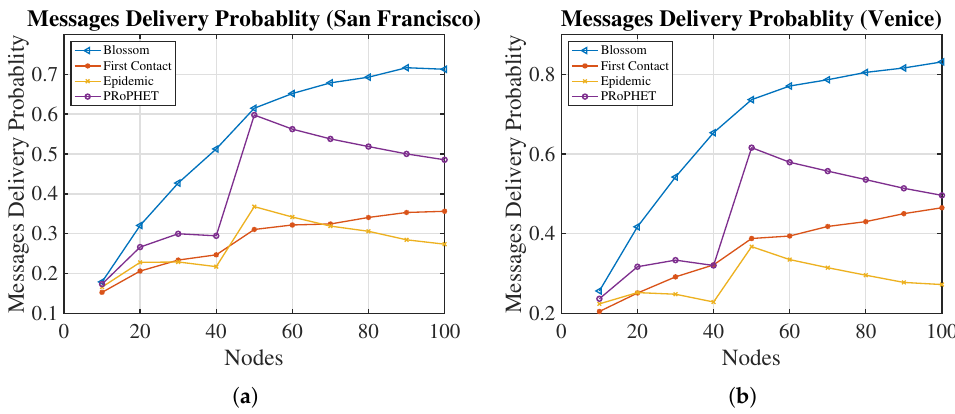
Figure 5. Comparison of routing algorithms for messages’ delivery probability. ( a ) San Francisco; ( b )